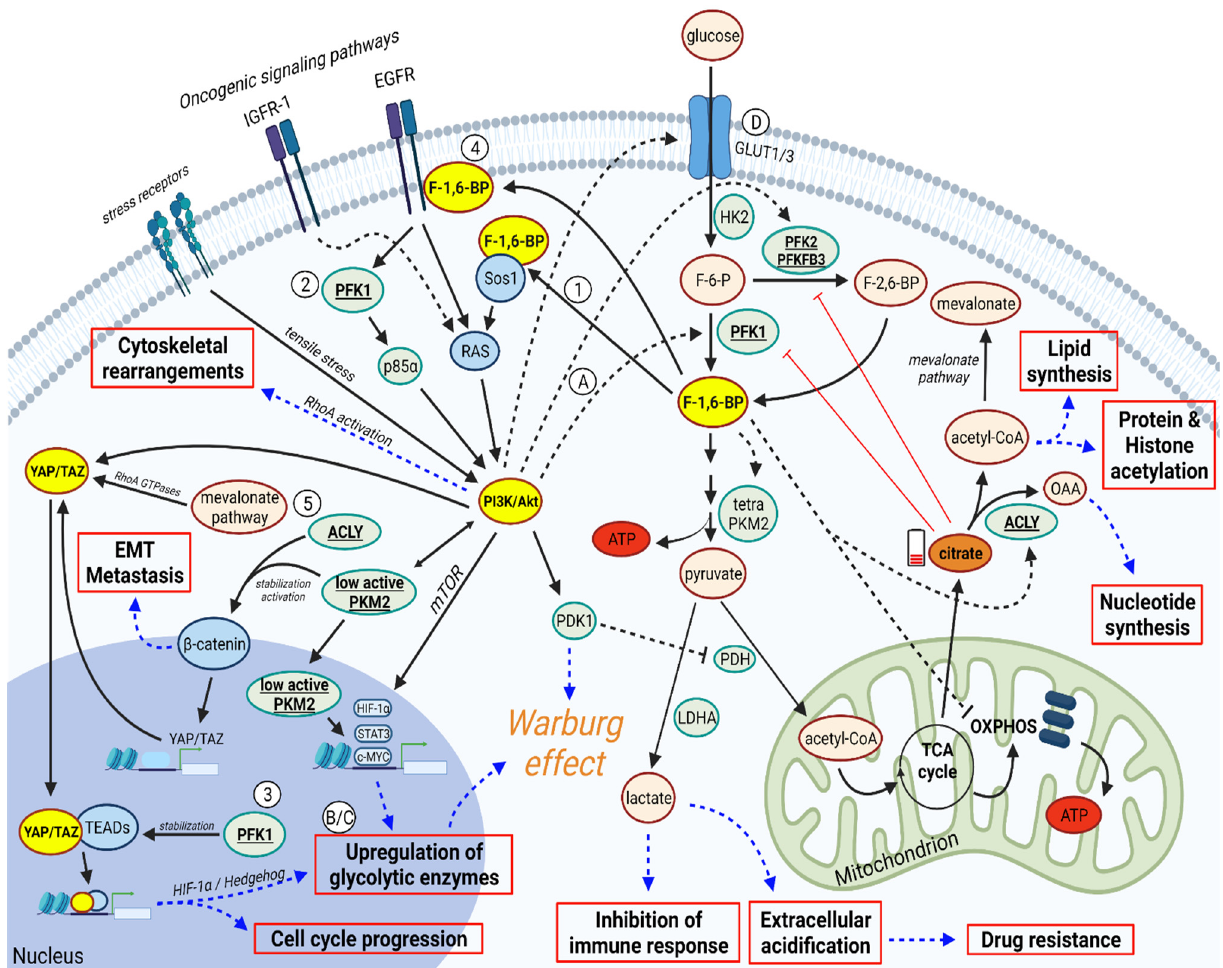
Figure 1. PI3K/AKT, YAP/TAZ, and PFK1/F-1,6-BP create a “Gordian Knot”, supporting cancer progression. In cancer cells, F-1,6-BP promotes glycolysis and activates ACLY, reducing citrate levels (which could inhibit PFK1 and PFK2) and increasing cytosolic acetyl-CoA (promoting lipid synthesis, protein and histone acetylation, and mevalonate pathway) and oxalacetate (OAA, sustaining nucleotide synthesis). Also, F-1,6-BP activates PI3K/AKT through Ras induction. PI3K/AKT can be also activated by tensile stresses from stress receptors. Once activated, PI3K/AKT promote transcription of glycolytic genes (though mTOR and low active PKM2), β -catenin stabilization (through PKM2, also promoted by ACLY), activation of glycolytic enzymes (favoring glycolysis), and YAP/TAZ activation (also induced by mevalonate pathway and β -catenin). Once translocated in the nucleus, YAP/TAZ mediate the transcription of genes promoting cell cycle progression and glycolysis. In parallel, ( i ) F-1,6-BP and AKT inhibit OXPHOS, thus increasing lactate production, which in turn inhibits the immune response and promotes extracellular acidification and drug resistance, and ( ii ) EMT is promoted by β -catenin and YAP/TAZ. Therapeutic strategies increasing citrate levels in cancer cells can inhibit glycolysis and F-1,6-BP production. Therefore, they may be useful to disrupt the Gordian Knot orchestrated by PI3K/AKT, YAP/TAZ, and PFK1/F-1,6-BP. Numbers (1–5) and uppercase letters (A–D) refer to regulatory mechanisms as described in Section 3 (numbers) and Section 4 (letters). Figure created with Biorender. (TEA)-domain (TEAD) family. Then, YAP/TAZ-TEAD complexes promote expression of